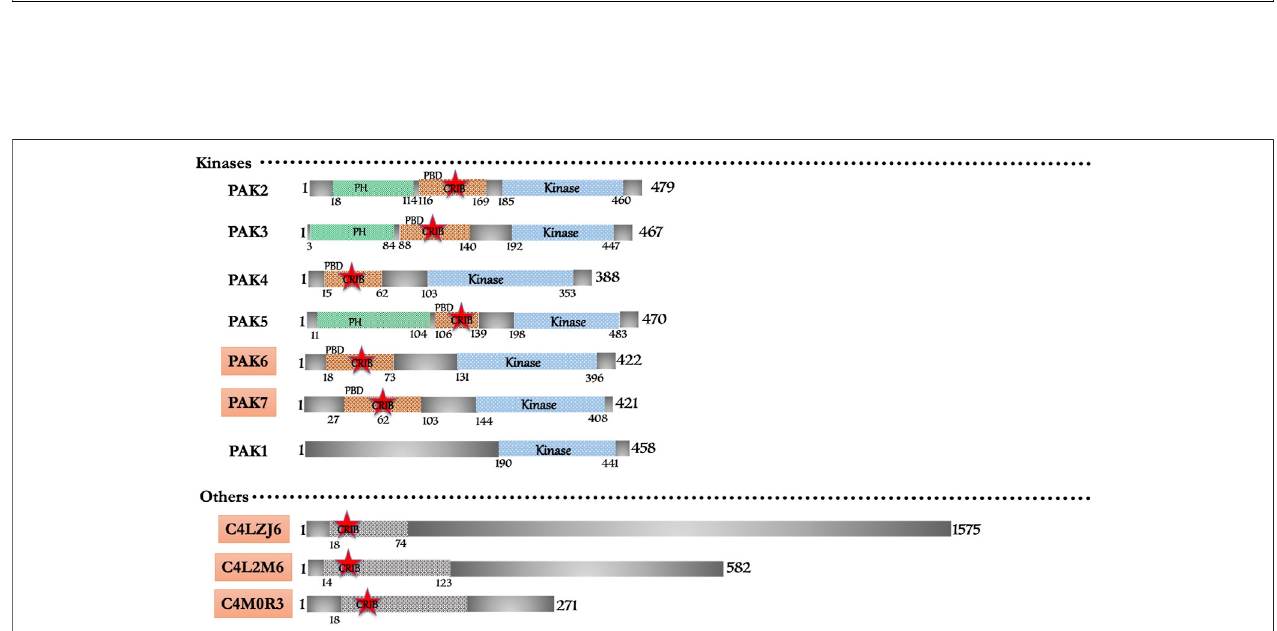
FIGURE 4 | Schematic diagram of domain organization of Entamoeba histolytica CRIB domain containing proteins. The abbreviations for the domains are: CRIB, Cdc42/Rac interactive binding; PBD, p21-activated binding domain PH, pleckstrin-homology. The proteins already known from the earlier literature, but not characterized yet are marked as green colored box. The proteins marked in orange (subtle effect) boxes are reported for the fi rst time in this in silico study and are completely uncharacterized. Footnote: In Entamoeba histolytica, PAK1 and PAK2 have been reported as crucial kinases in the survival of this pathogen and are intricately involved in the phagocytic process. PAK3 and PAK4 characterization also showed a promising role in pathogenesis. Structural and biophysical characterization isthe prospectivefuture ofthe already recognized proteins apart from theones identi fi ed inthis study. Experimental research on these proteins will lead to new potential drugs targets against the single drug (metronidazole) available in the market. The development of new drugs is necessary due to the reports of drug resistance found in laboratory cultured amoebic cells.